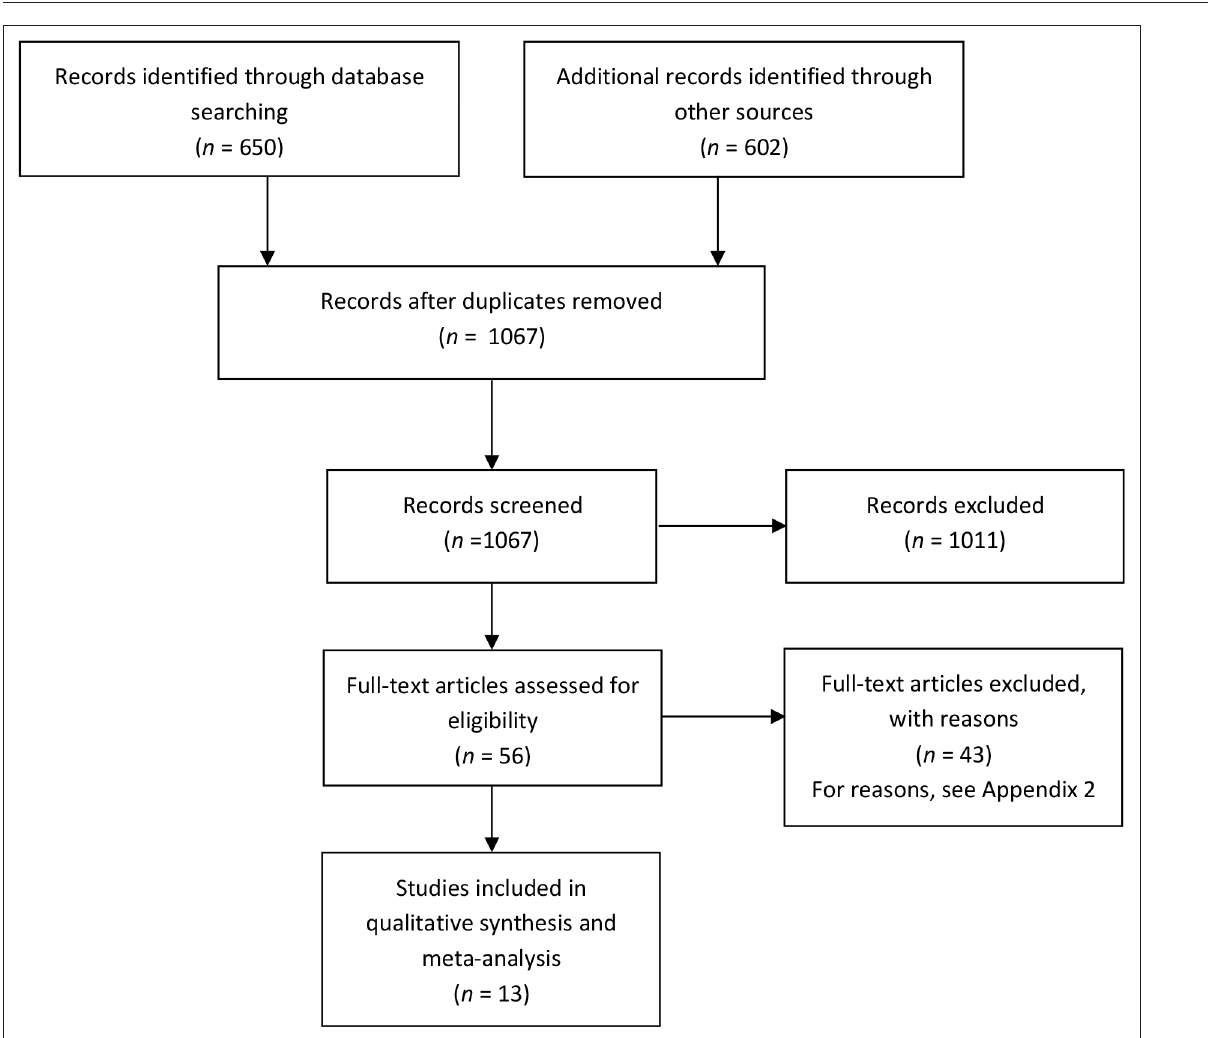
Figure 1 PRISMA flow diagram